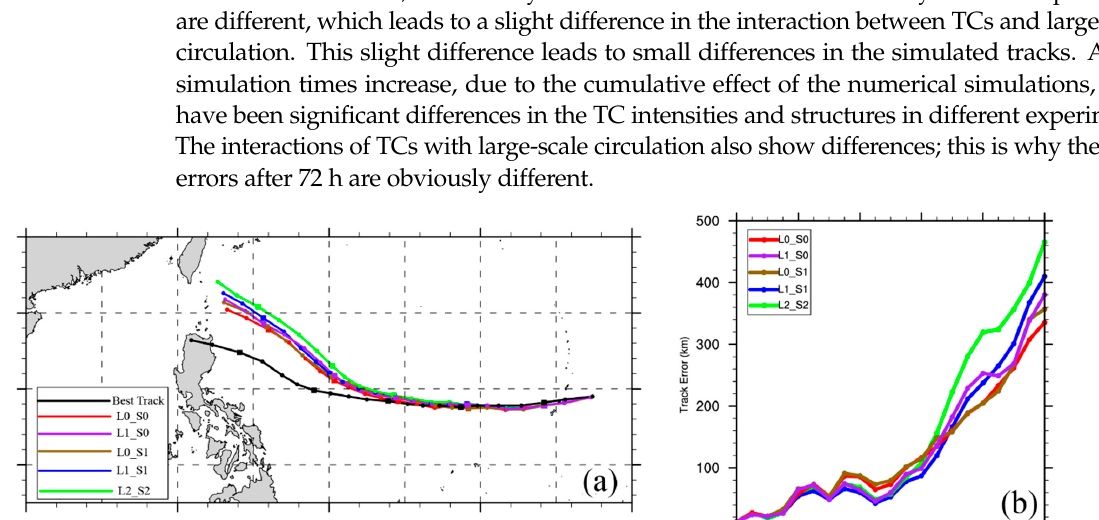
Table 1. Numerical experimental design in detail.